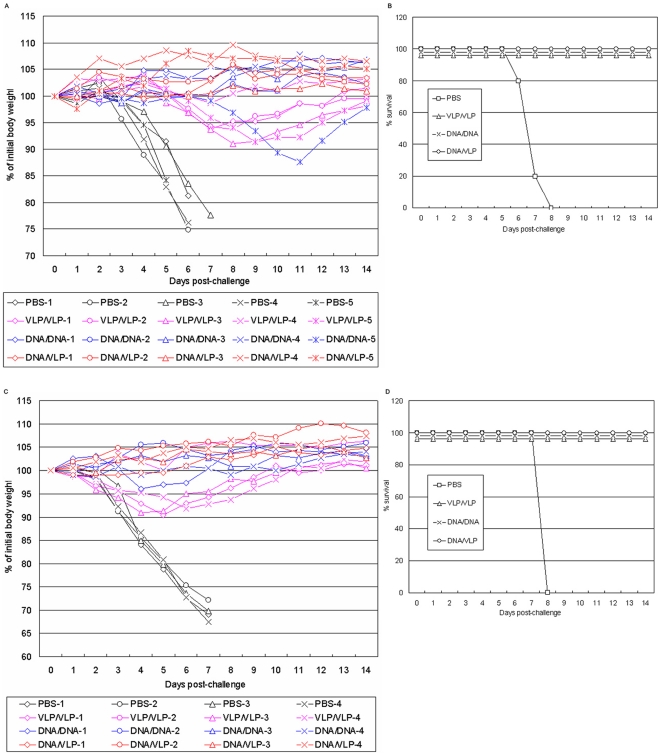
Comparison of vaccine efficacy elicited with heterologous DNA-VLP prime-boost versus homologous DNA-DNA, VLP-VLP prime-boost strategies in mice following 10 MLD50 of homologous (A/Shenzhen/406H/06, clade 2.3.4) and heterologous (A/Cambodia/P0322095/05, clade 1) H5N1 virus challenge.A) Percentage of original body weight in individual mice after challenged with 10 MLD50 of homologous (A/Shenzhen/406H/06, clade 2.3.4) H5N1 virus. Black color: PBS control group; red color: heterologous DNA-VLP prime-boost group; pink color: homologous VLP-VLP prime-boost group; blue color: homologous DNA-DNA prime-boost group. B) Survival rates after challenged with 10 MLD50 of homologous (A/Shenzhen/406H/06, clade 2.3.4) H5N1 virus. Survival rate was calculated based on percent survival within each experimental group (n = 5 mice per experimental group; *, P<0.05, Kaplan-Meier survival analysis). Open square: PBS control group; open triangle: homologous VLP-VLP prime-boost group; open circle: heterologous DNA-VLP prime-boost group; cross: homologous DNA-DNA prime-boost group. C) Percentage of original body weight in individual mice after challenged with 10 MLD50 of heterologous (A/Cambodia/P0322095/05, clade 1) H5N1 virus. Black color: PBS control group; red color: heterologous DNA-VLP prime-boost group; pink color: homologous VLP-VLP prime-boost group; blue color: homologous DNA-DNA prime-boost group. D) Survival rates after challenged with 10 MLD50 of heterologous (A/Cambodia/P0322095/05, clade 1) H5N1 virus. Survival rate was calculated based on percent survival within each experimental group (n = 4 mice per experimental group).